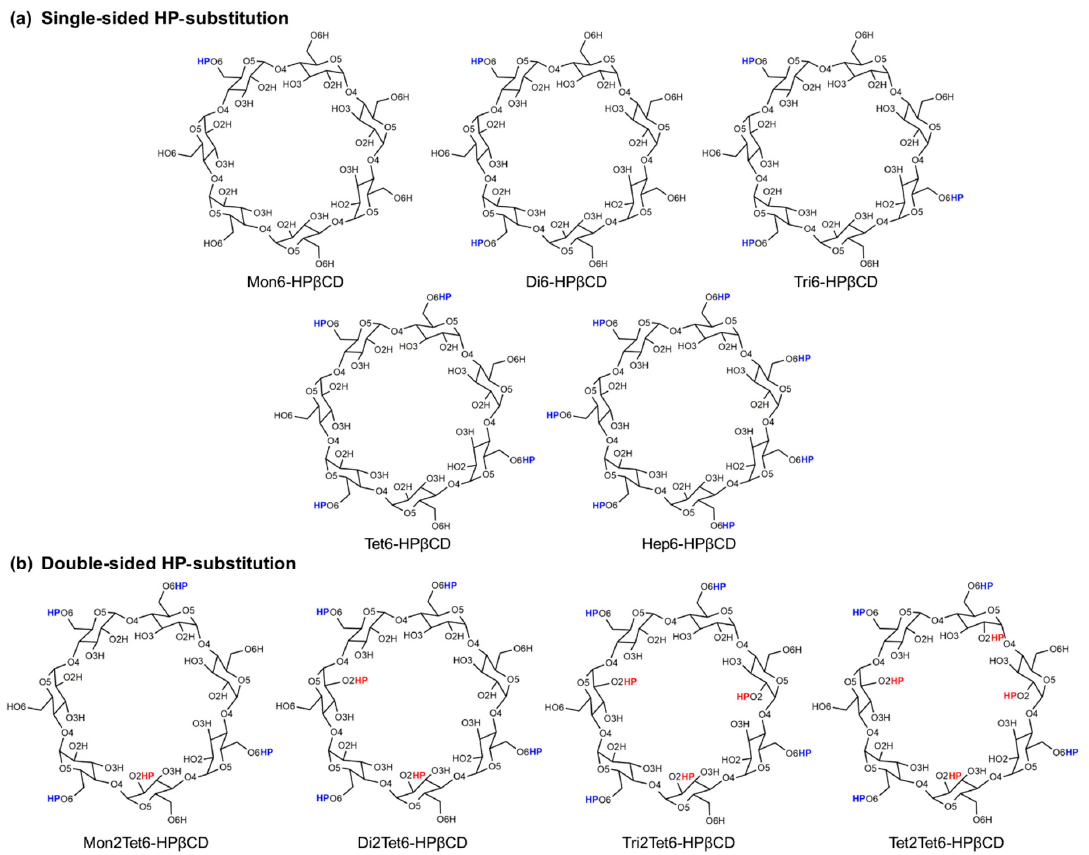
Figure 2. Models introducing 2-hydroxypropyl (HP) groups at the O2 (red) and/or O6 (blue) positions on glucose subunits.